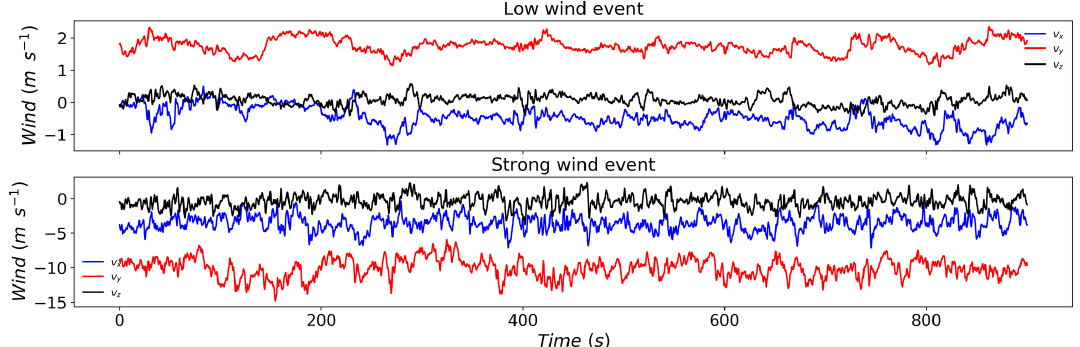
Figure 6. Temporal evolution of the 100Hz wind data from a 3D sonic anemometer for the low (top) and strong (bottom) wind events used in this